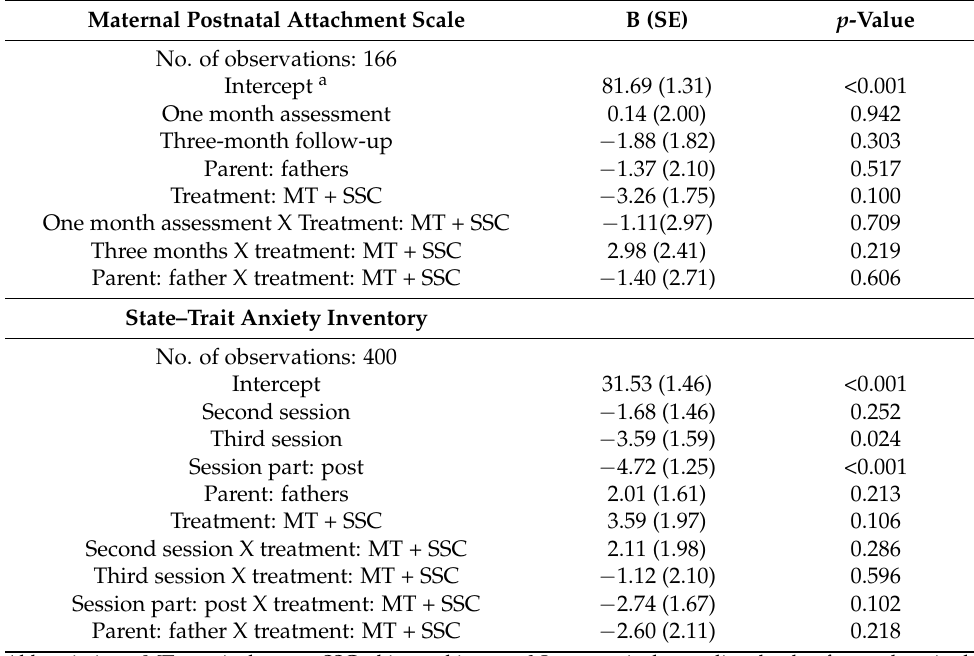
Table 6. Linear mixed effects models of parental outcomes across